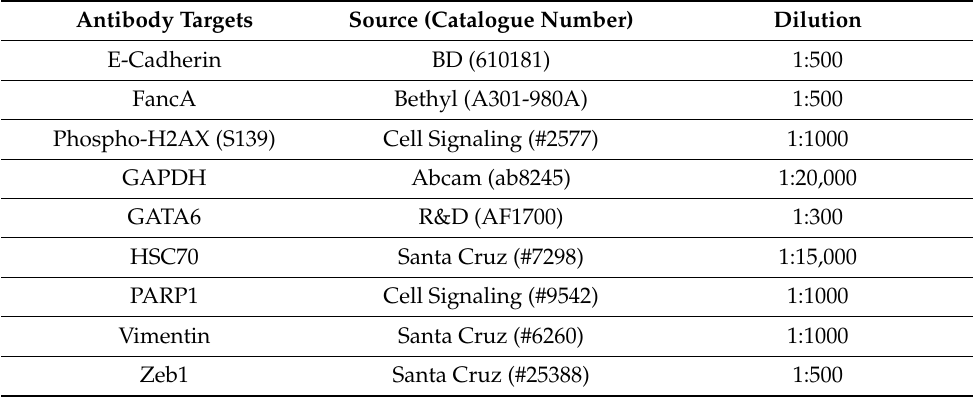
Table 1. Antibodies used for immunoblot